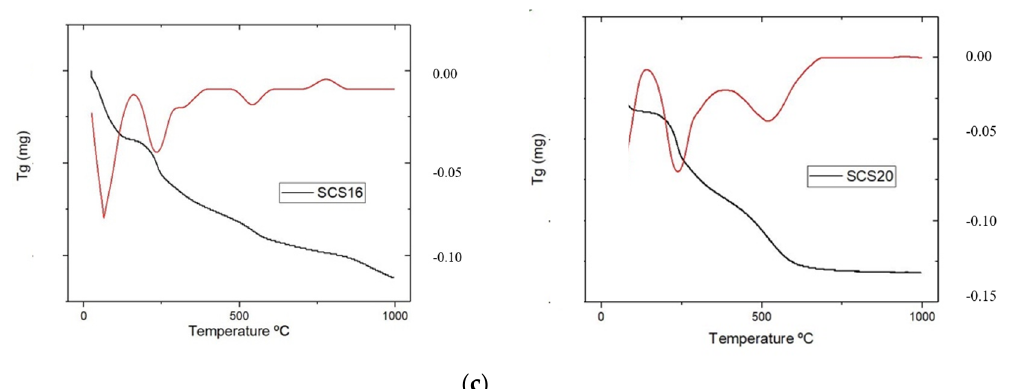
Figure 3. ( a ) TG and DTG of SCS20, SCS8 aerogels, and pure silica from TEOS. ( b ) TG and DTG of SCS4 aerogel with the three different weight drops. ( c ) TG (black) and DTG (red) curves of the SCS4, SCS8, SCS16, and SCS20 aerogels.